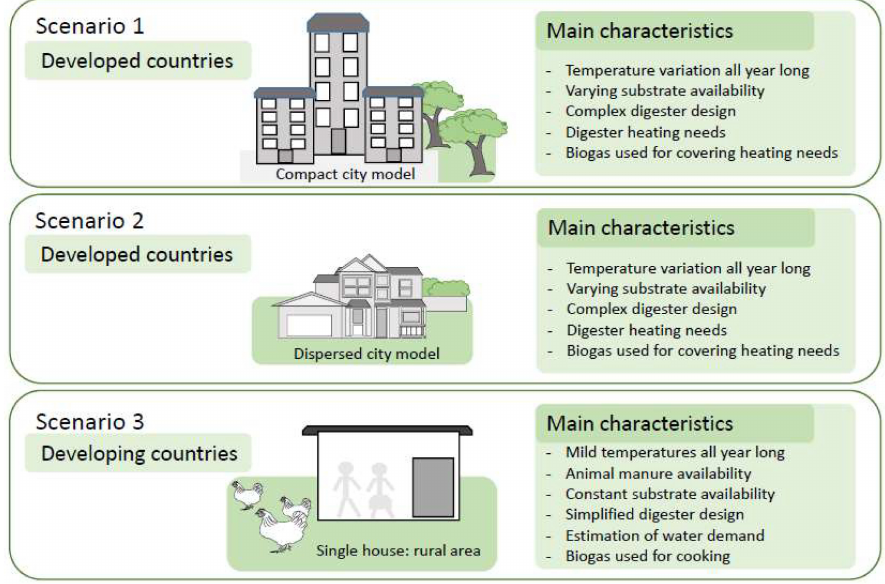
Figure 2. Schematization of the analyzed